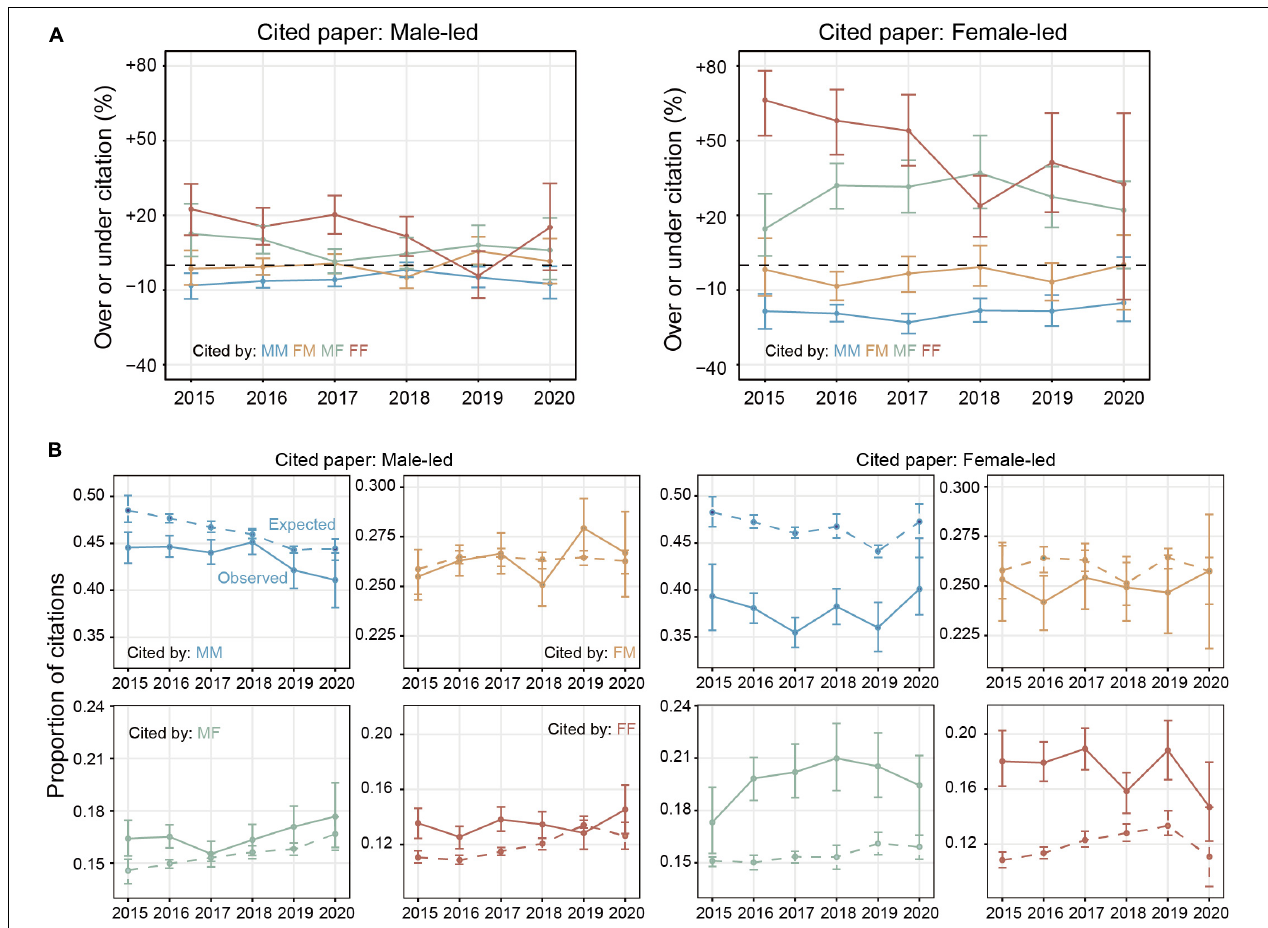
FIGURE 3 | Time-trends in citation rates across gender of the cited and citing author. (A) The degree of over-citation and under-citation of male-led and female-led papers over time. The gaps of MM, FM, MF, and FF citations between observed and expected proportions were increasing at a rate of 0.13, 0.60, –1.31, and –1.47% per year within male-led cited papers compared to 0.67, 0.39, 1.45, and –6.74% per year within female-led cited papers. The points represent overall over-citation and under-citation. (B) The observed (solid line) and expected (dashed line) proportions of citation within male-led and female-led citing papers over time. The points represent the observed or expected citation rates during a given year. Error bars represent the 95% CI of each rate, which were calculated from 1,000 bootstrap resampling